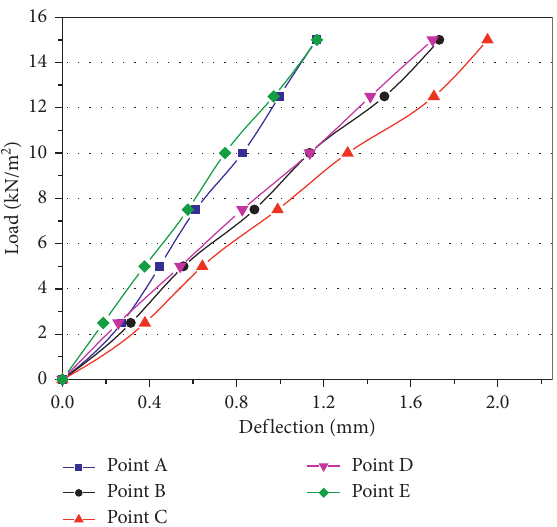
Figure 7: Load-deflection curves of the single-span simply sup- ported formwork specimens.